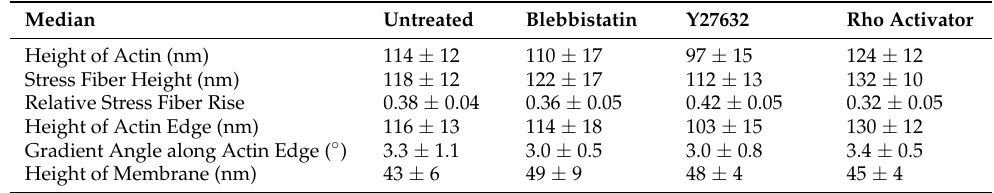
Table 1. Summary of the medians ± std from height and angle analyses of the actin cytoskeleton and membrane of untreated cells and cells treated with blebbistatin, Y27632 and Rho activator.